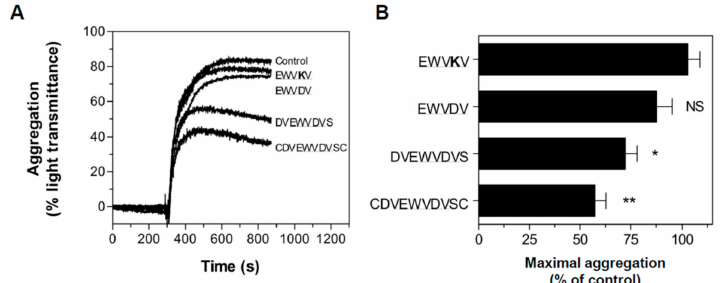
Figure 4. Inhibition of platelet aggregation by P-selectin antagonists. Human platelet-rich plasma was incubated with the indicated peptide antagonists (100 µ M) or bu ff er. Platelet aggregation was initiated by 10 µ M adenosine diphosphate (ADP). ( A ) Representative aggregation curves in the presence of bu ff er, EWV K V, EWVDV, DVEWVDVS, and CDVEWVDVSC. ( B ) Maximal aggregation in the presence of EWVDV-based peptides. Data are means ± S.E.M, n = 3; NS: not significant.